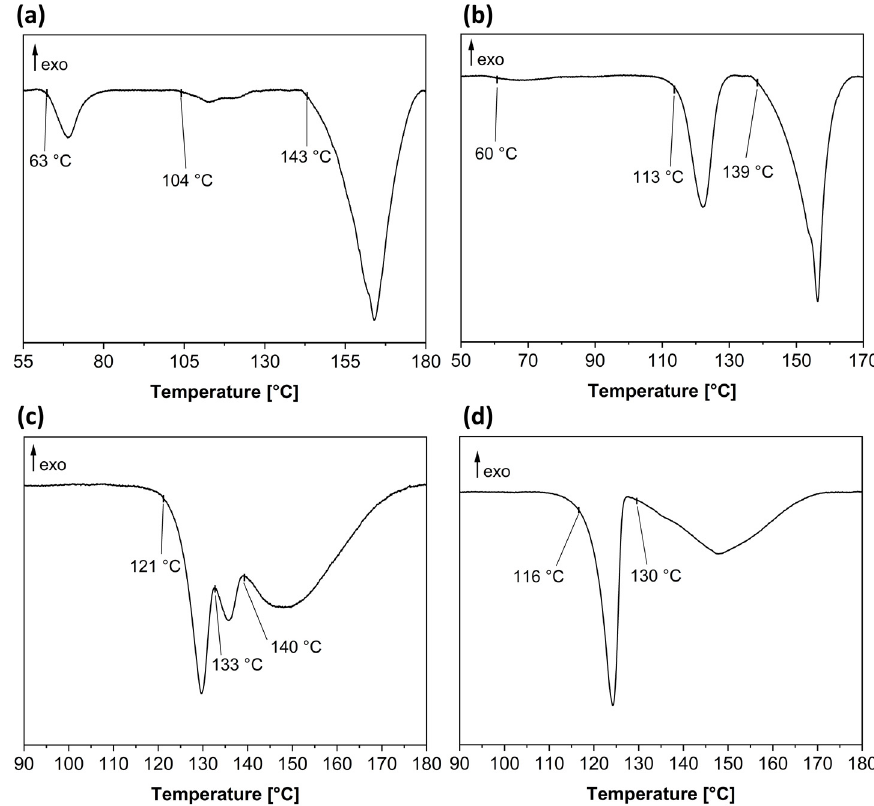
Figure 7. DSC data of 1 : D − 4 • H 2 O ( a ) and 1 : L − 4 • H 2 O ( b ) samples grown from aqueous hexafluoropropan-2-ol solution; 1 : D − 4 ( c ) and 1 : DL − 4 ( d ) samples produced by milling. DSC was heated at 5 °C min − 1 ; only important temperature ranges are shown for clarity.